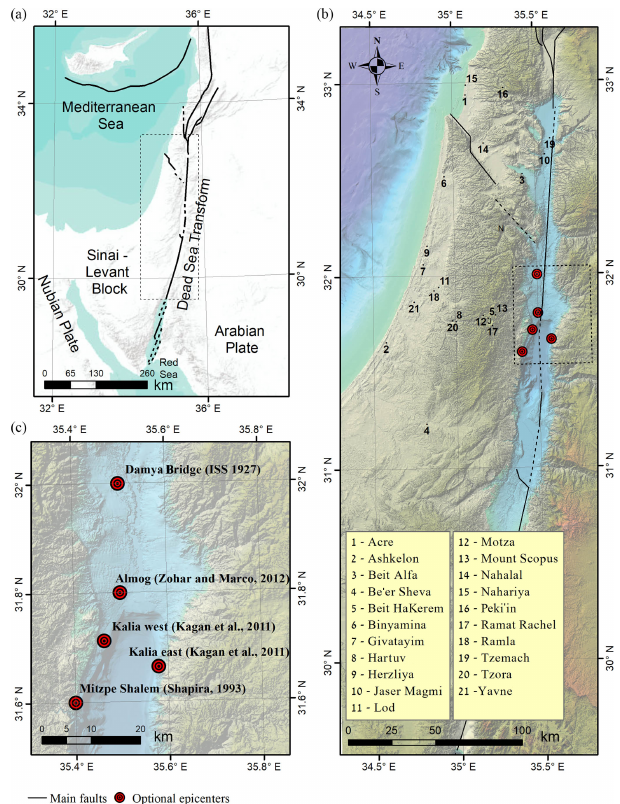
Figure 2. Research area: (a) Middle East area with the main tec- tonic elements. (b) Proposed epicenters for the 1927 earthquake event with all sites that were investigated placed over a 25m dig- ital terrain model (DTM) image (Hall, 2008). (c) Detailed location of the proposed epicenters. Also shown are sites mentioned in the text: Jerusalem (J) and Nablus (N).